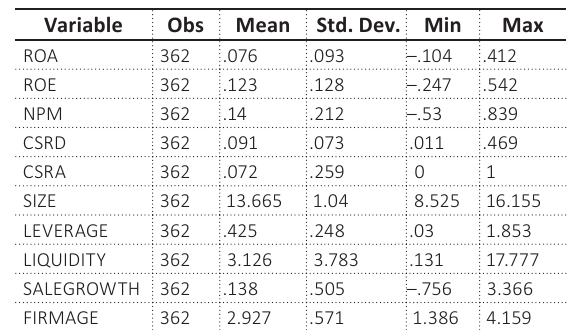
Table 5. Descriptive statistics for small-cap firms